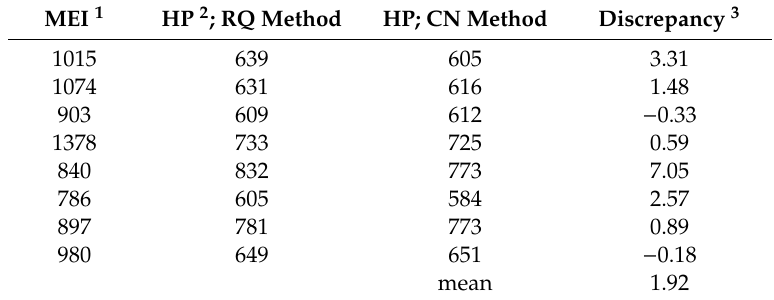
Table 4. Heat production (kJ/kg BW 0.75 day) of 8 lactating Murciano-Granadina goats measured by the Respiration Quotient (RQ)and Carbon Nitrogen (CN) methods.